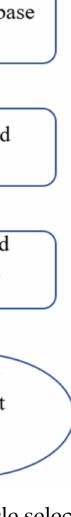
Figure 1. Article selection workflow of 963 papers resulting from the WOS query. Table 2. Overview of the main scientific